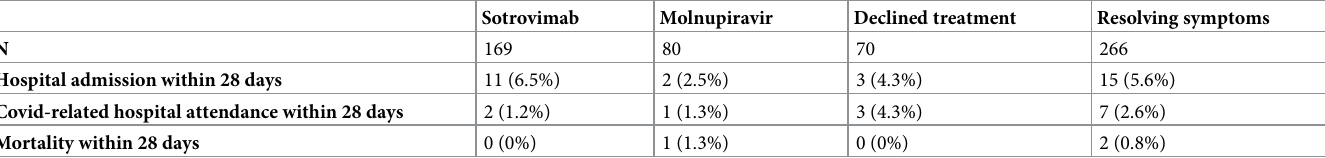
Table 3. 28 day hospital admission and mortality.